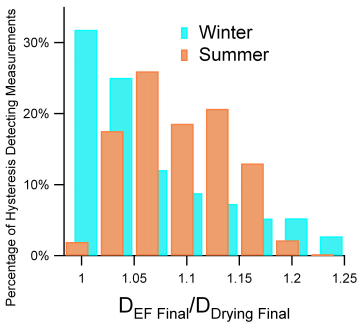
Fig. 11. A frequency plot illustrating the variation in residual water content of the less hydrated state between the two